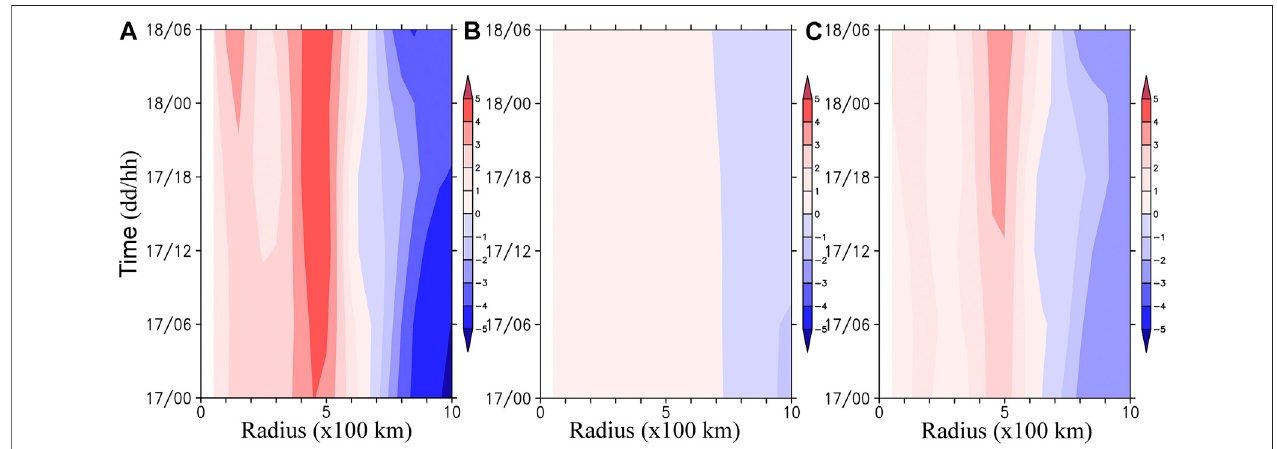
FIGURE 6 | Time-radius cross-section of the azimuthal-mean integrated divergence of the AAM fl ux (AAMFD, shaded, 10 5 m 3 s − 1 h − 1 ) over low levels (averaged from 1,000 hPa to 900 hPa) during the RI period of Helene (A) total AAMFD (B) AAMFD associated with the low-frequency circulation, and (C) AAMFD associated with the synoptic-scale